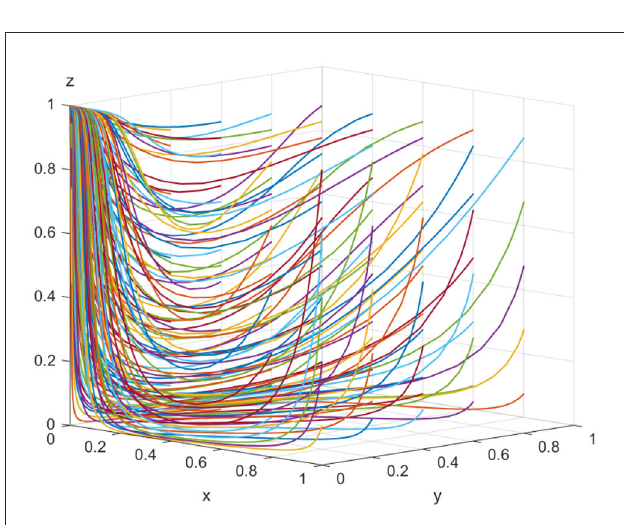
FIGURE4 Simulation diagram of the system evolution 50 times under array